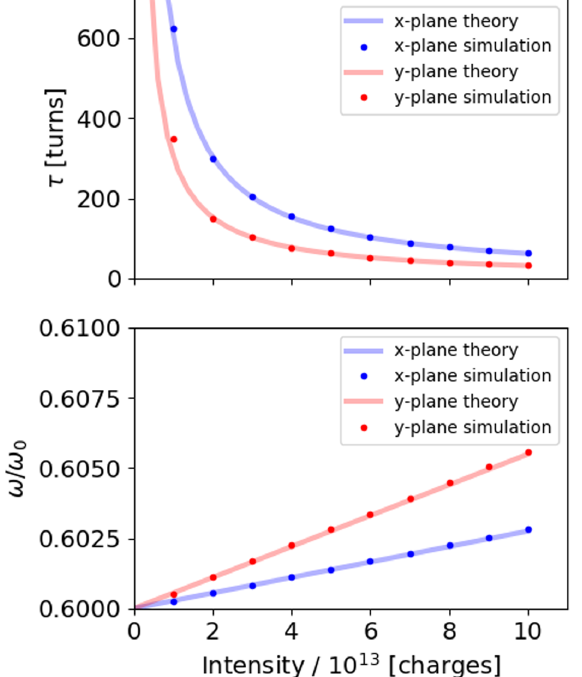
FIG. 3. P y HEADTAIL simulations (with dots) compared to theory [16] for driving impedance only (with full lines) for the horizontal (blue) and the vertical (red) planes. The rise time of the most unstable mode is shown at the top while the normalized frequency shift is shown at the